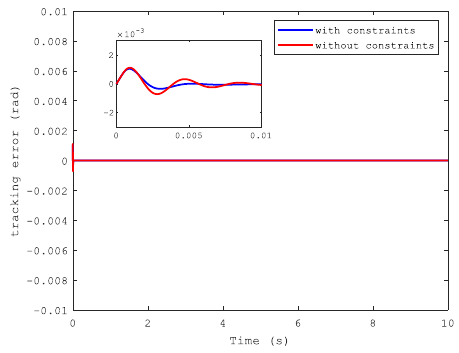
Figure 4. Tracking error.